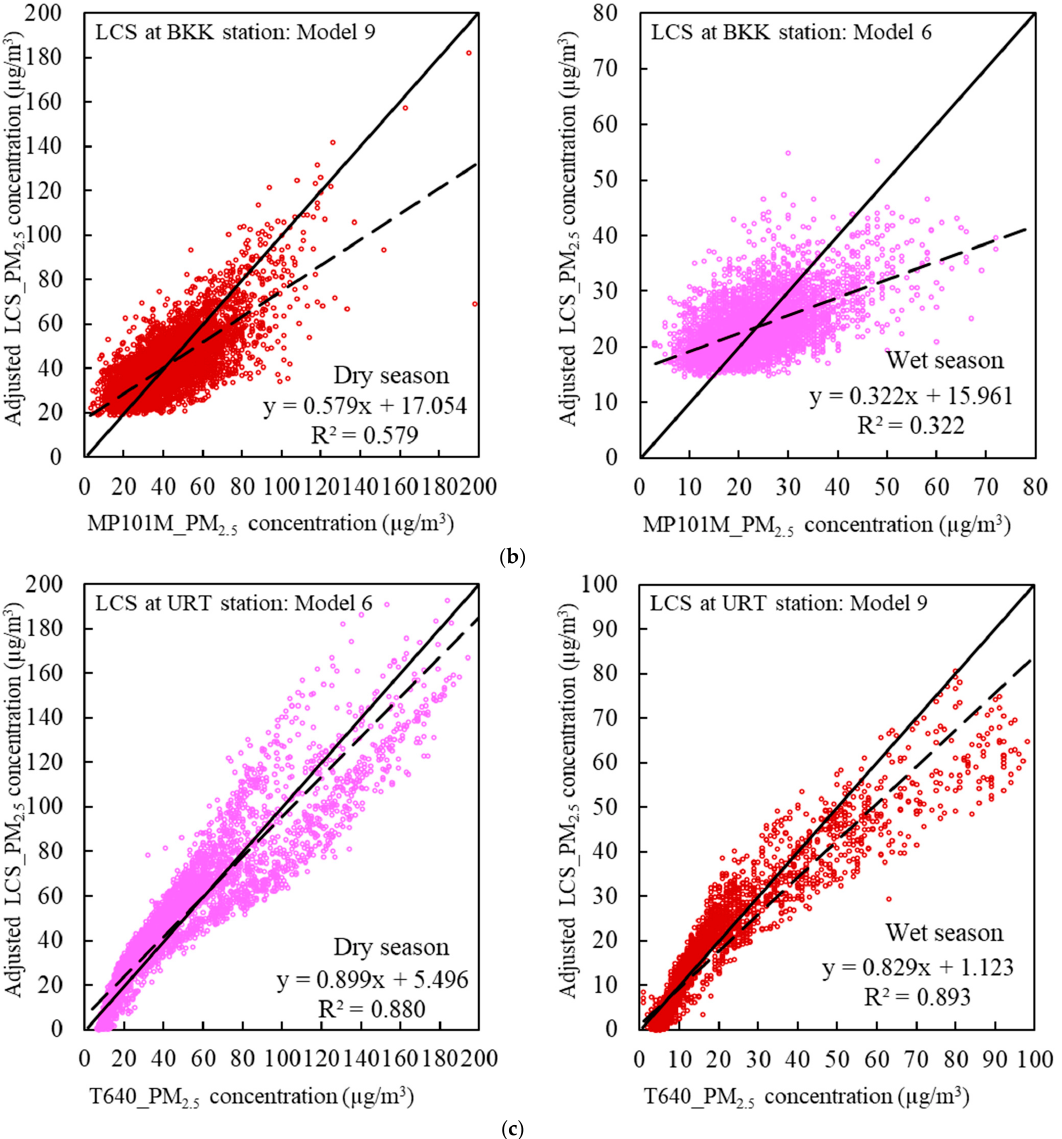
Figure 7. Correlation between LCS and FEM 1-h PM 2.5 concentrations using MRL models during both seasons at ( a ) CM, ( b ) BKK and ( c ) URT—model 6: pink scatters, model 9: red points. The solid line is the line with slope =1 while the dashed line represents the fitting. Table 6. MLR calibration: constants for the best fitting models.